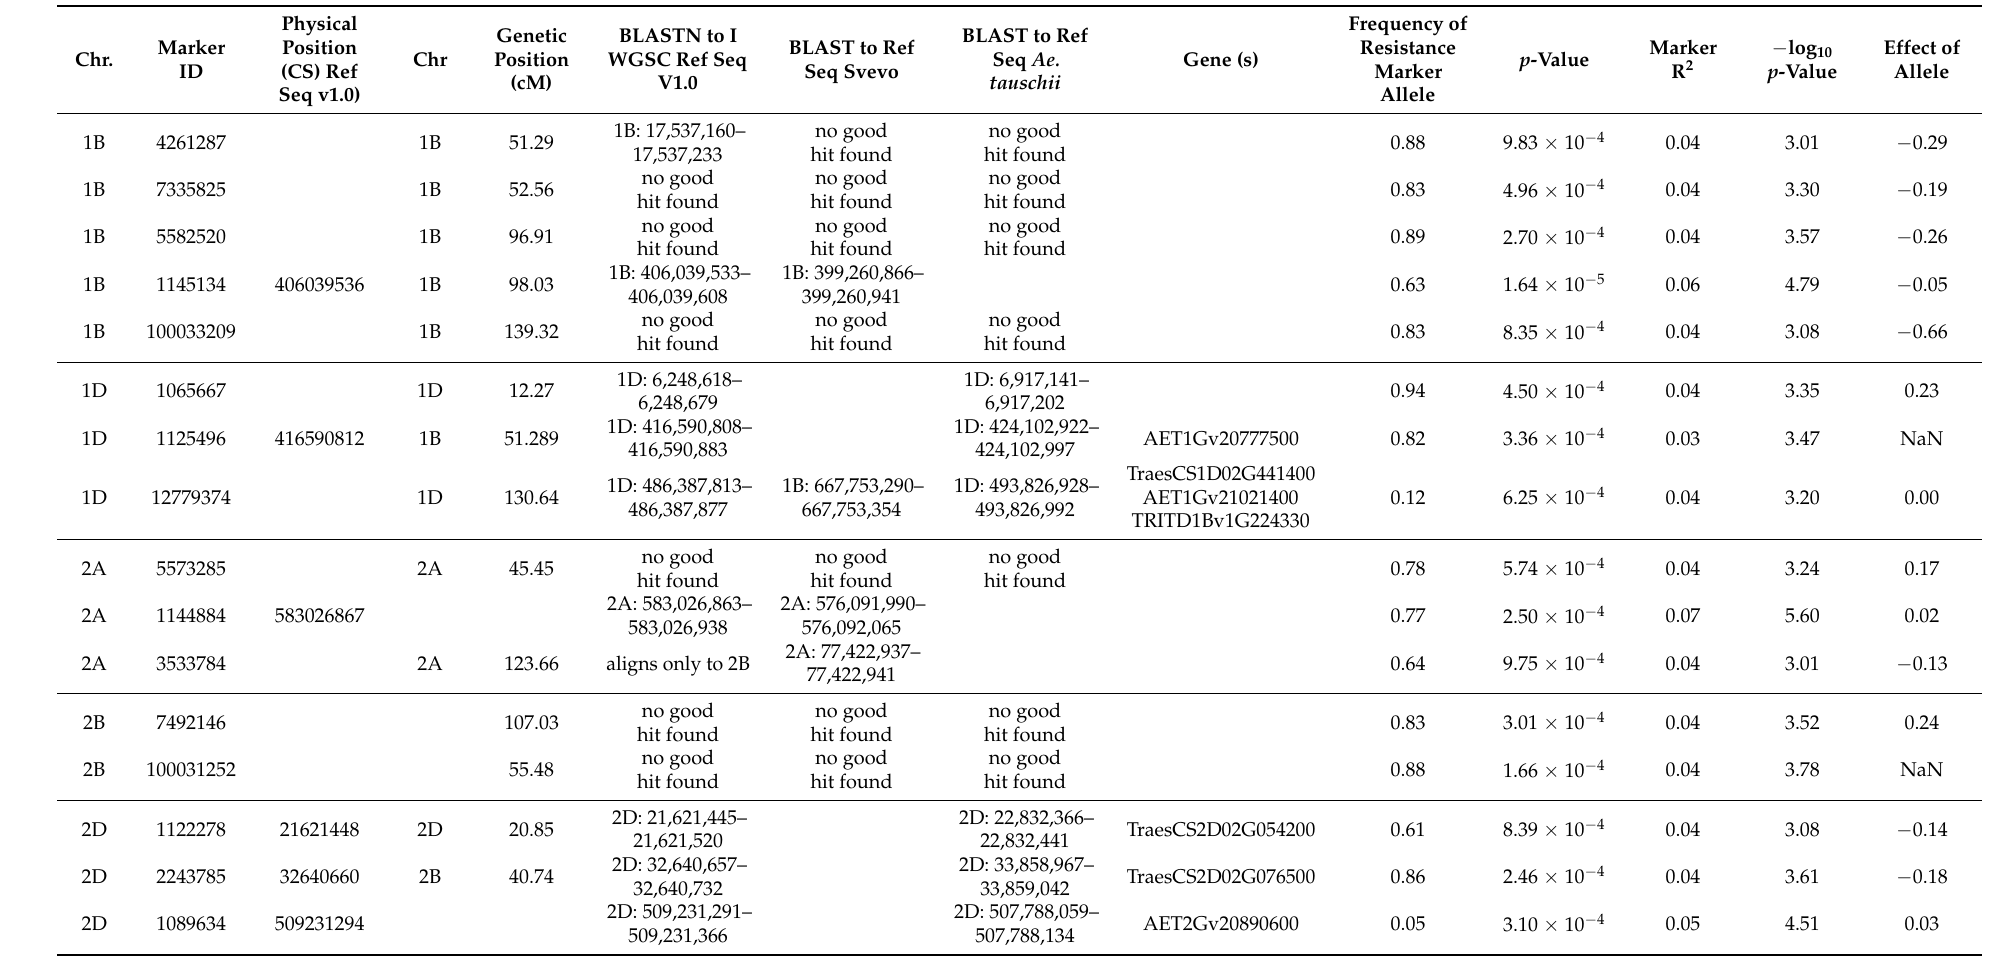
Table 2. Significant marker–trait associations for seedling resistance to spot blotch, their position in different reference genomes, associated candidate genes, and GWAS statistics. The table contains the physical position based on Chinese Spring (CS) reference genome, the chromosome and the genetic position based on cM, the BLAST results against the CS, Svevo, and Ae. tauschii reference genomes, genes, freq. of resistance markers, p -values, Marker R 2 . − log 10 p -values and effect of allele.